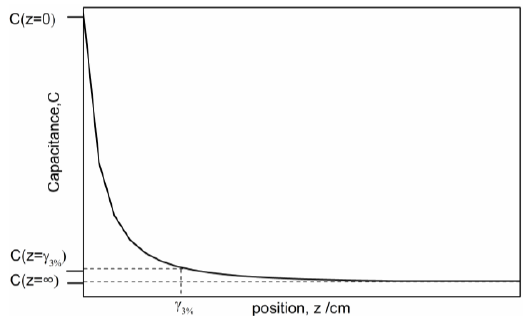
Figure 4. Analytical curve of C - z in theory .